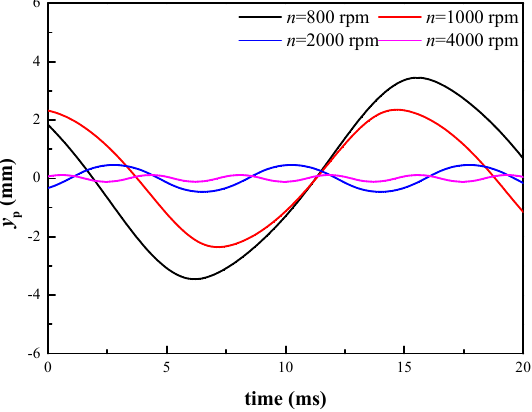
Figure 10. Displacements of different valve spool rotation speeds when the supply pressure is 4 MPa.